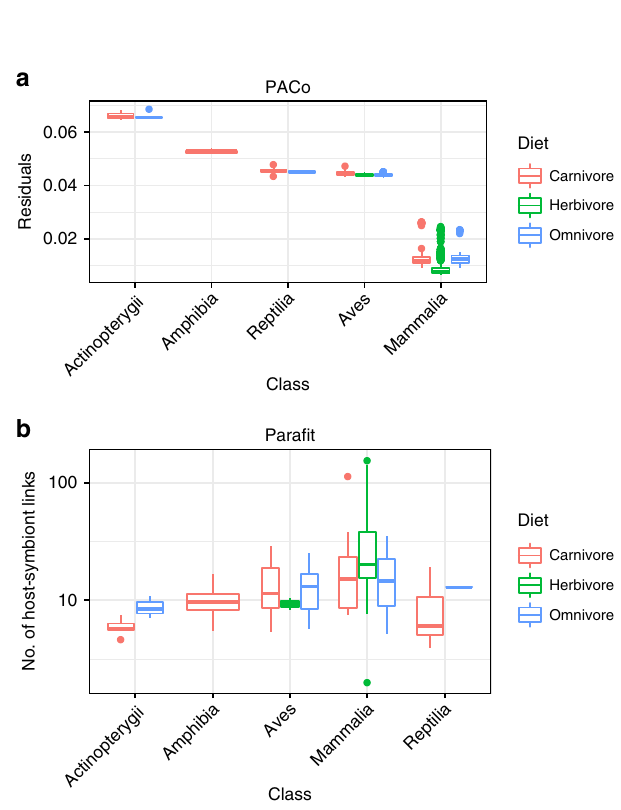
Fig. 5 Procrustean approach to cophylogeny (PACo) and Para fi t show a stronger cophylogeny signal for Mammalia versus non-mammals. a Boxplots of PACo residuals between hosts and operational taxonomic units (smaller residuals means a stronger cophylogeny signal), with residuals grouped by host class and diet. b Boxplots of signi fi cant host – symbiont links as determined by Para fi t analysis, with links grouped by host class and diet. For both PACo and Para fi t, 1000 permutations were performed on each of the 100 dataset subsets. Box centerlines, edges, whiskers, and points signify the median, interquartile range (IQR), 1.5× IQR, and >1.5× IQR, respectively. Source data are provided as a Source Data fi